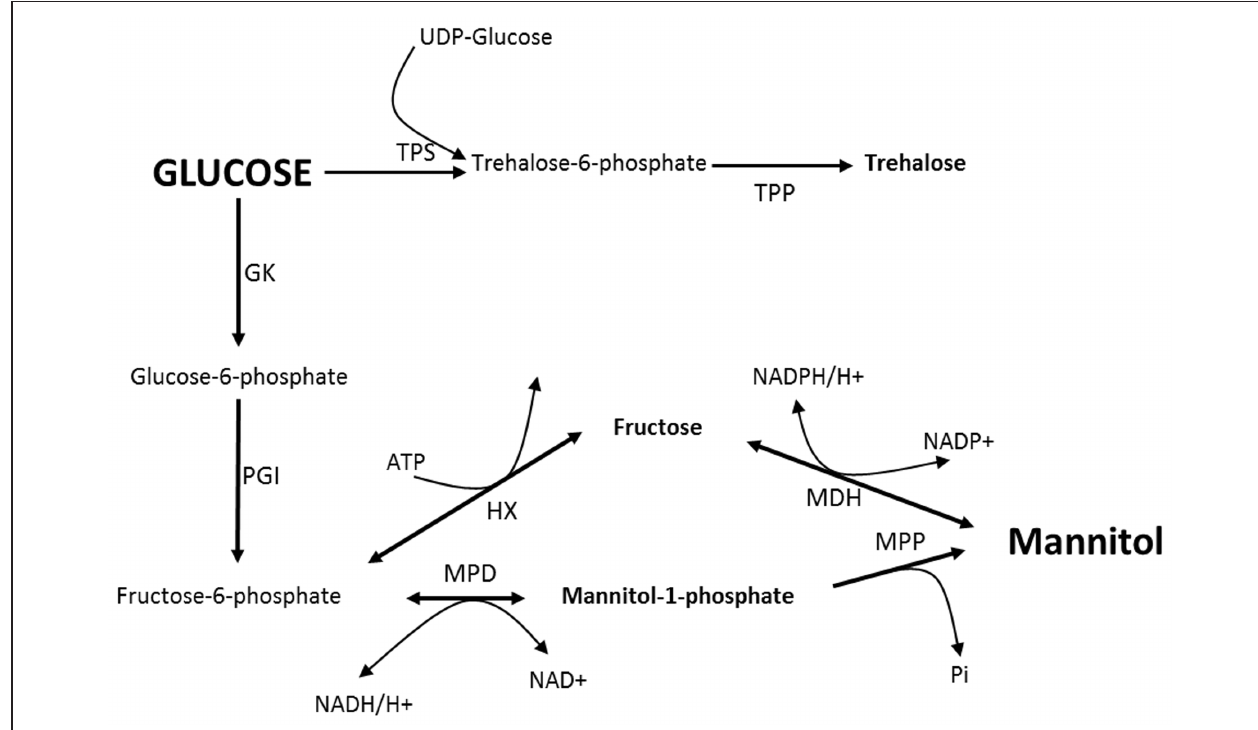
FIGURE 1 | Proposed mannitol cycle in fungi. MDH, Mannitol dehydrogenase; MPP, Mannitol-1-P phosphatase; MPD, Mannitol-1-P dehydrogenase; HX, Hexokinase; PGI, Phosphoglucose isomerase; GK, Glucokinase; TPS, Trehalose-6-P synthase; TPP, Trehalose-6-P phosphatase.